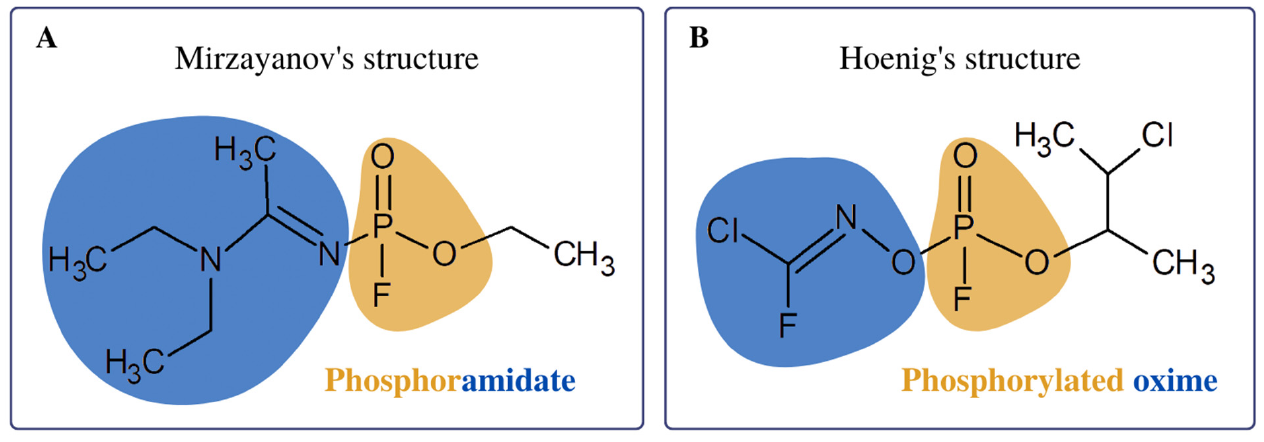
Figure 2. The chemical structures of Novichok A-234: ( A ) phosphoramidate and ( B ) phosphorylated oxime.